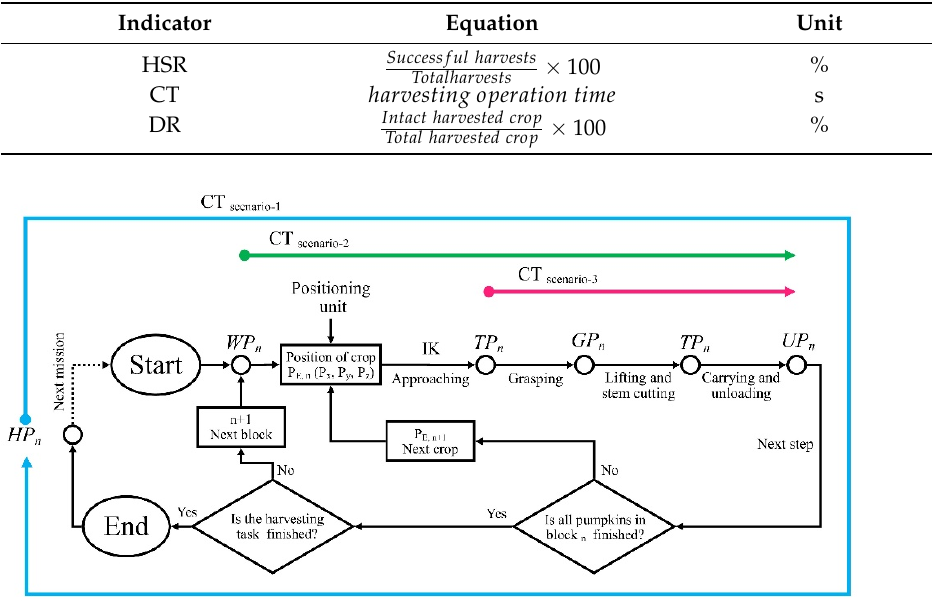
Table 2. Harvesting performance indicators.